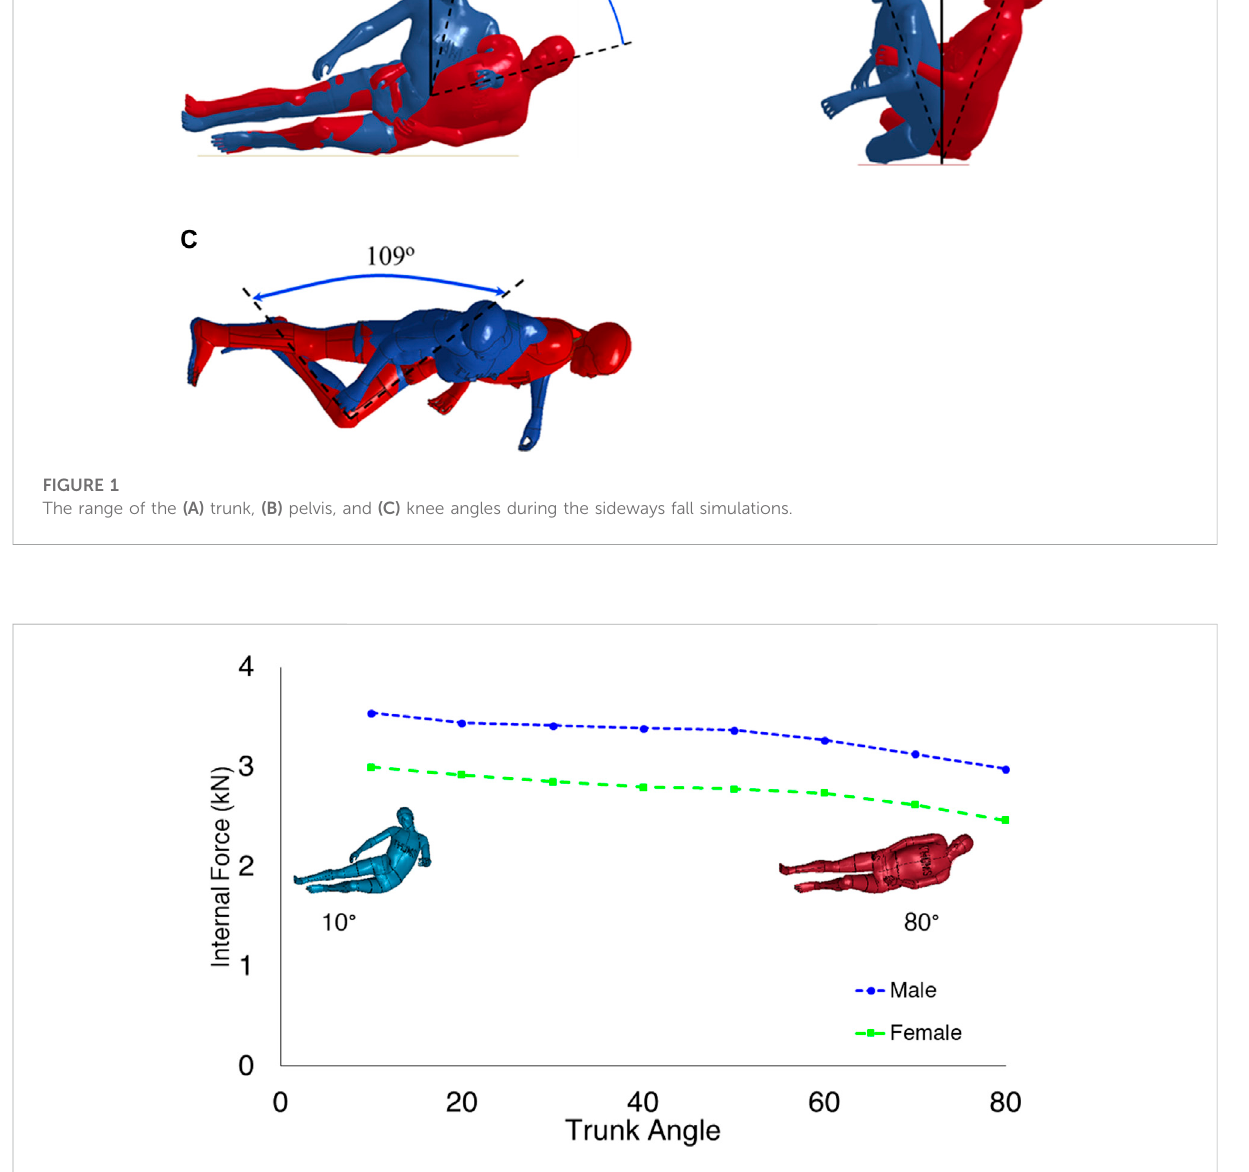
FIGURE 2 Comparison of the proximal femur forces in different trunk angles. The proximal femur forces decrease as the trunk angle reaches the horizontal body con fi